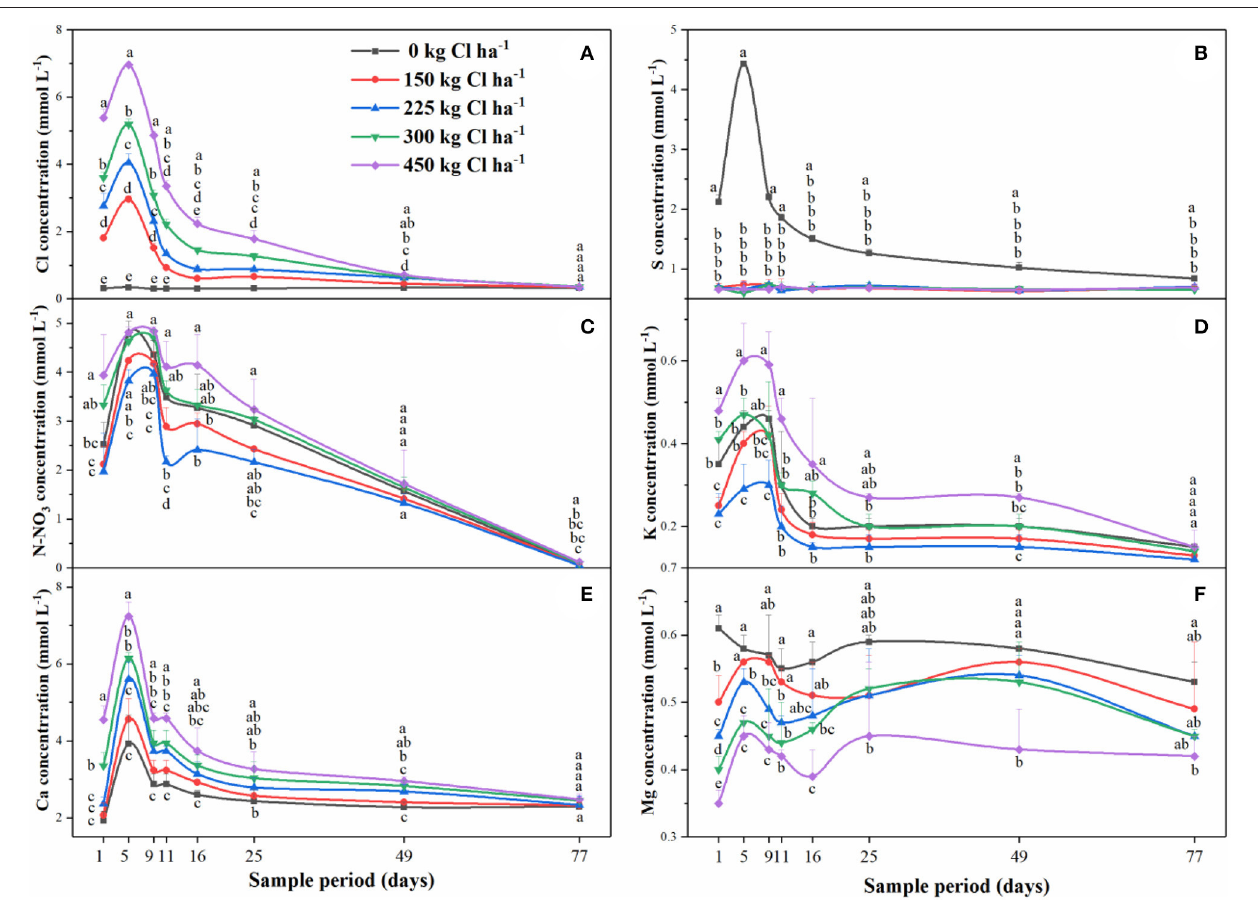
FIGURE 6 | The concentration of Cl (A) , S (B) , N-NO 3 (C) , K (D) , Ca (E) , and Mg (F) dynamics changes in leachate by application of Cl-containing fertilizers on sweet orange. Bars are means of three replicates ± SD. Different letters (a, b, c, d, e) in each sub-figure represent significant differences at ( P <